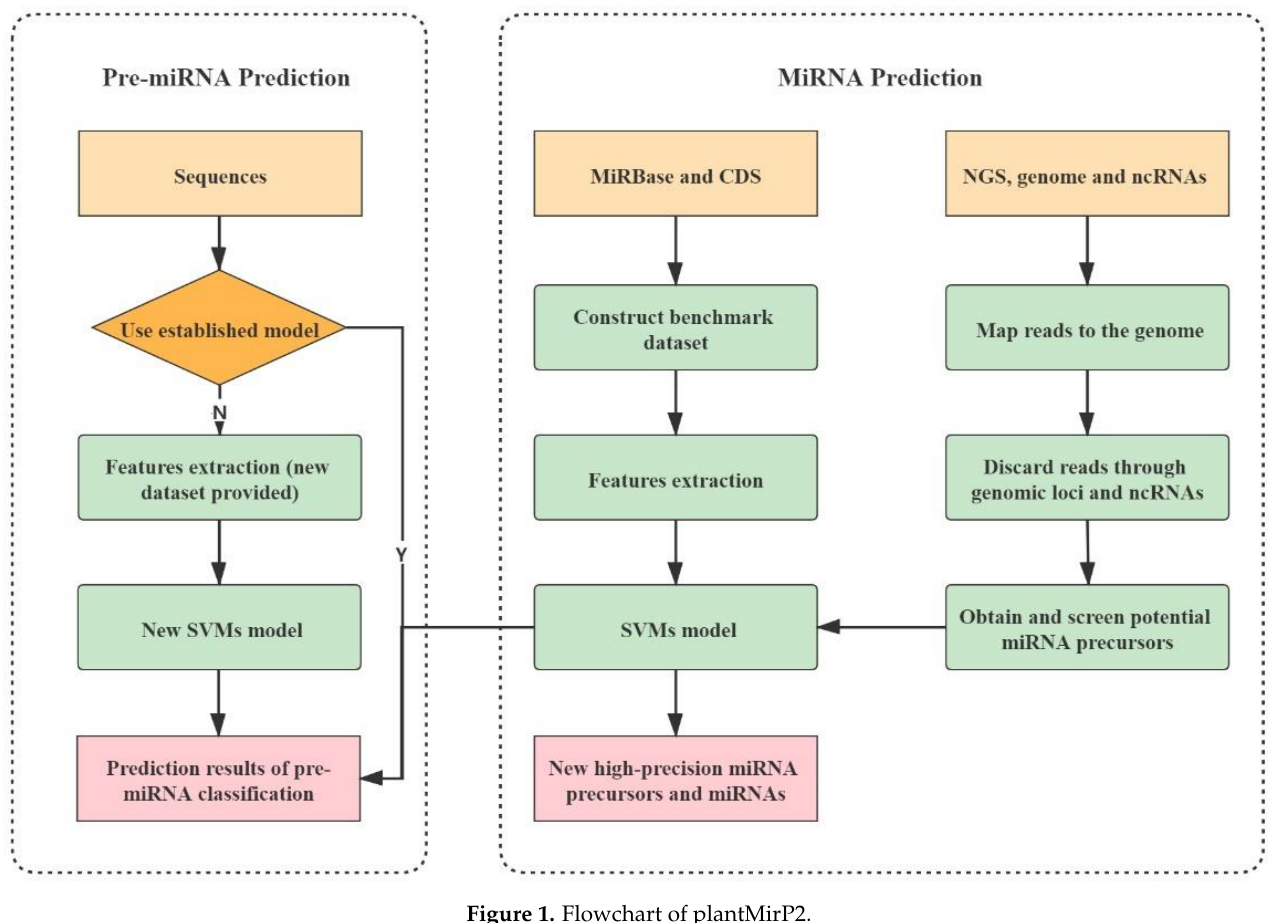
Figure 1. Flowchart of plantMirP2.